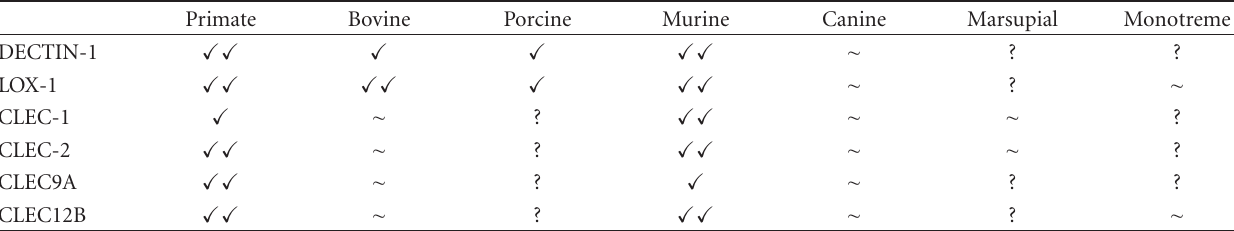
Table 1: Members of the DECTIN-1 cluster in di ff erent mammalian families.